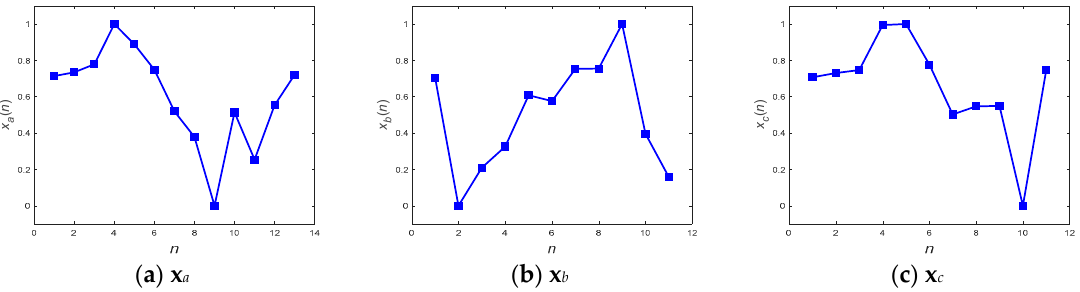
Figure 8. Examples in different lengths for operational elaboration.